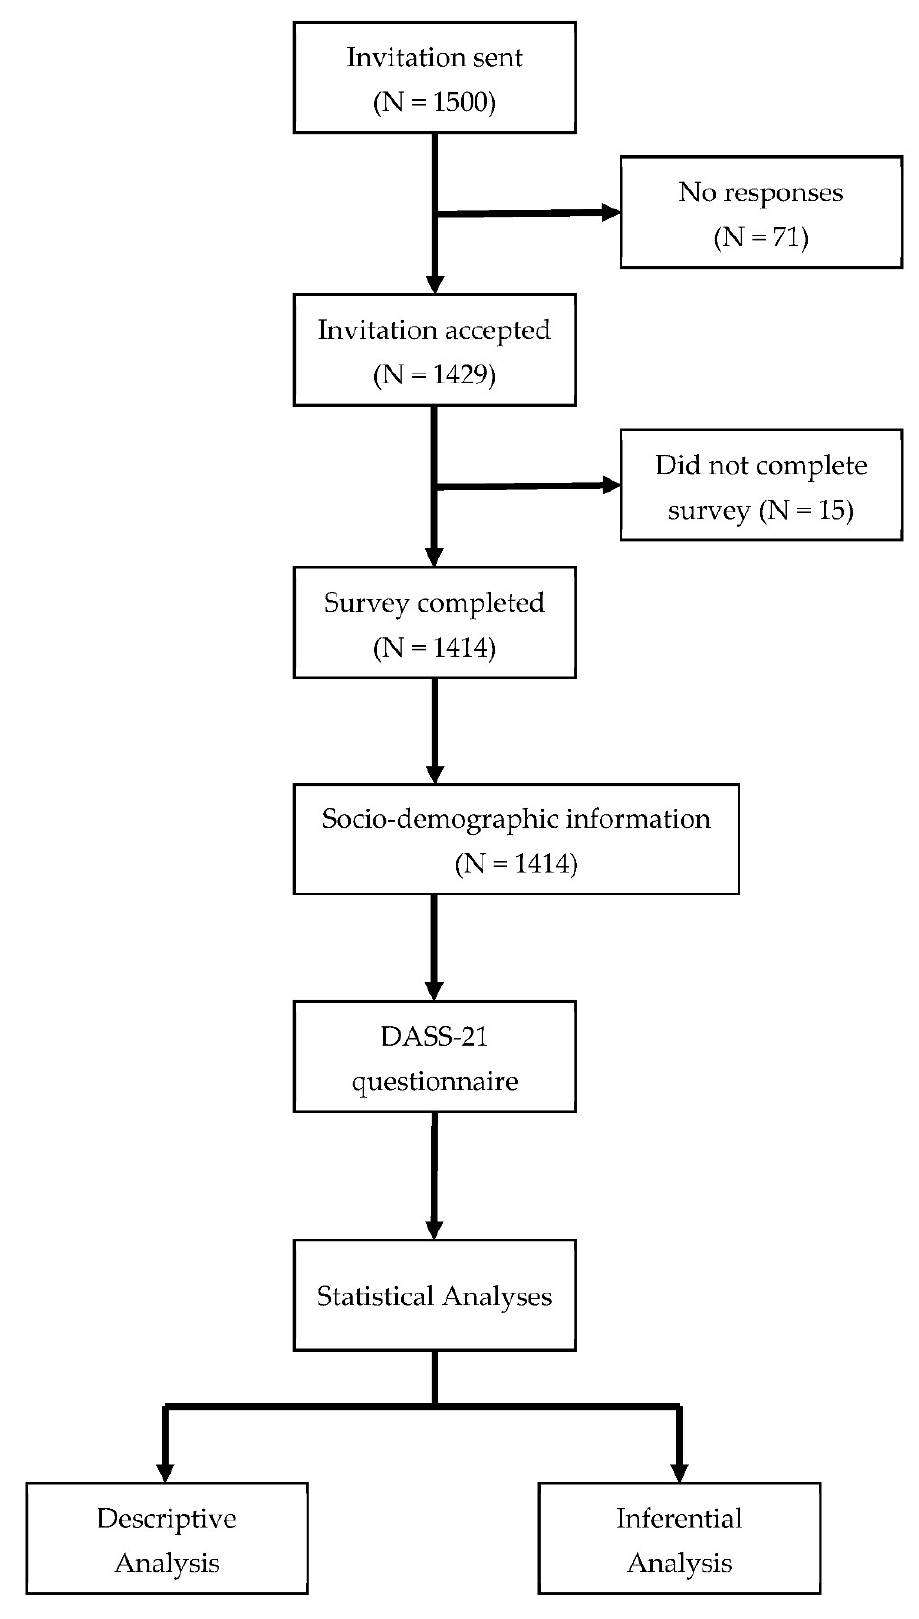
Figure 1. Survey flowchart. Figure 1. Survey Table 2. Demographic characteristics of the sample.